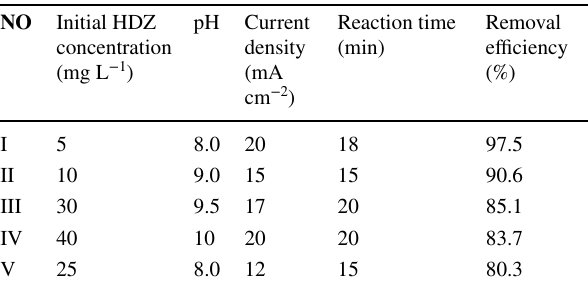
Table 4 Suggested approaches to achieve maximum HDZ